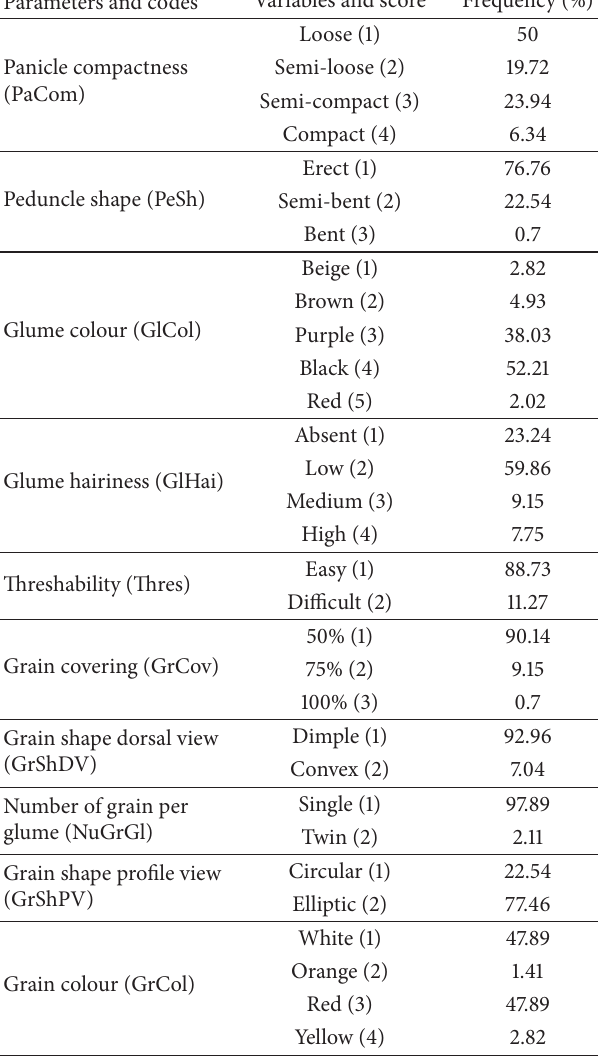
Table 1: Frequencies of the different phenotypes recorded within the various qualitative morphological parameters considered to describe the sorghum collection